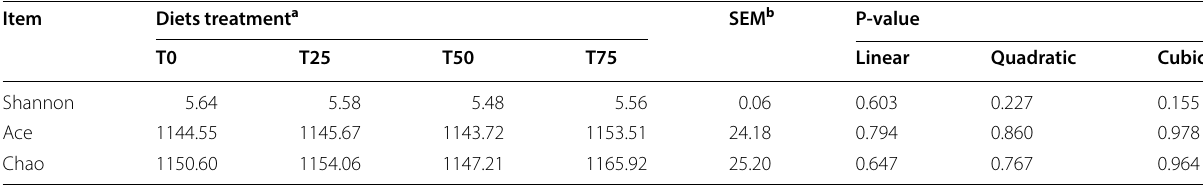
a T0, BPS replaces 0% of WCS; T25, BPS replaces 25% of WCS; T50, BPS replaces 50% of WCS; T75, BPS replaces 75% of WCS. BPS, Broussonetia papyrifera silage; WCS, whole corn silage b SEM, standard error of mean